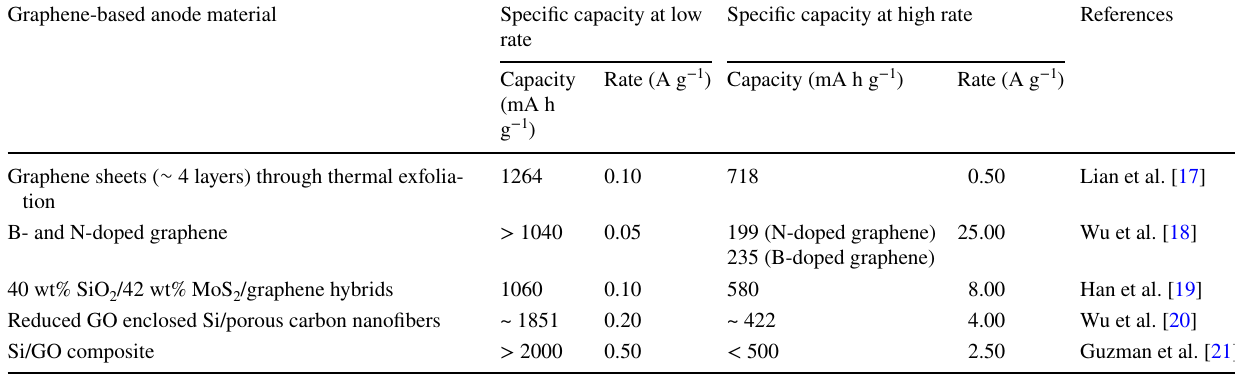
Table 1 Cycling rate dependency of specific capacities as reported in the literature Graphene-based anode material Specific capacity at low